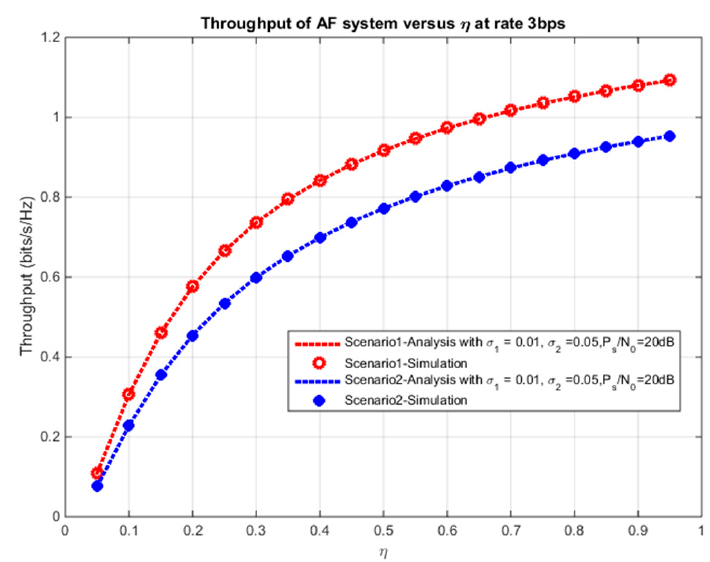
Figure 4. The throughput versus η .